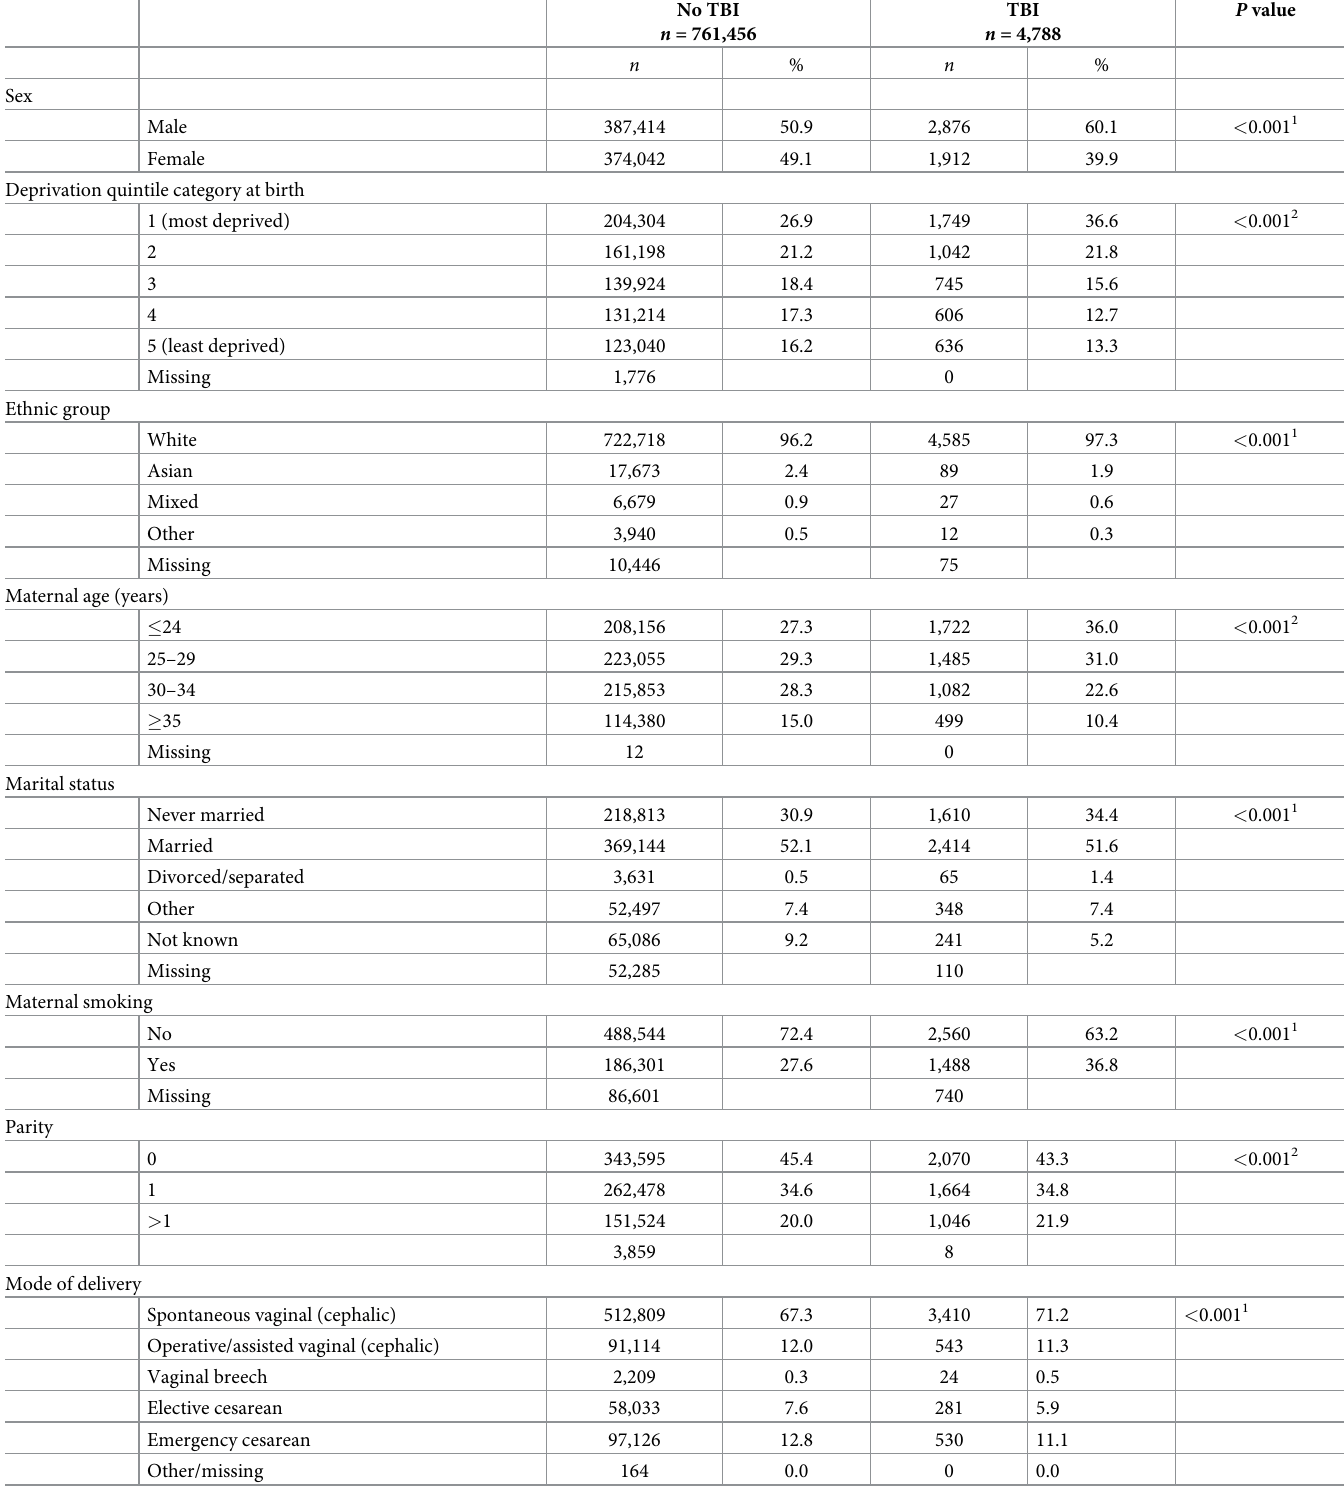
Table 1. Characteristics of study participants by whether or not they were previously hospitalised for